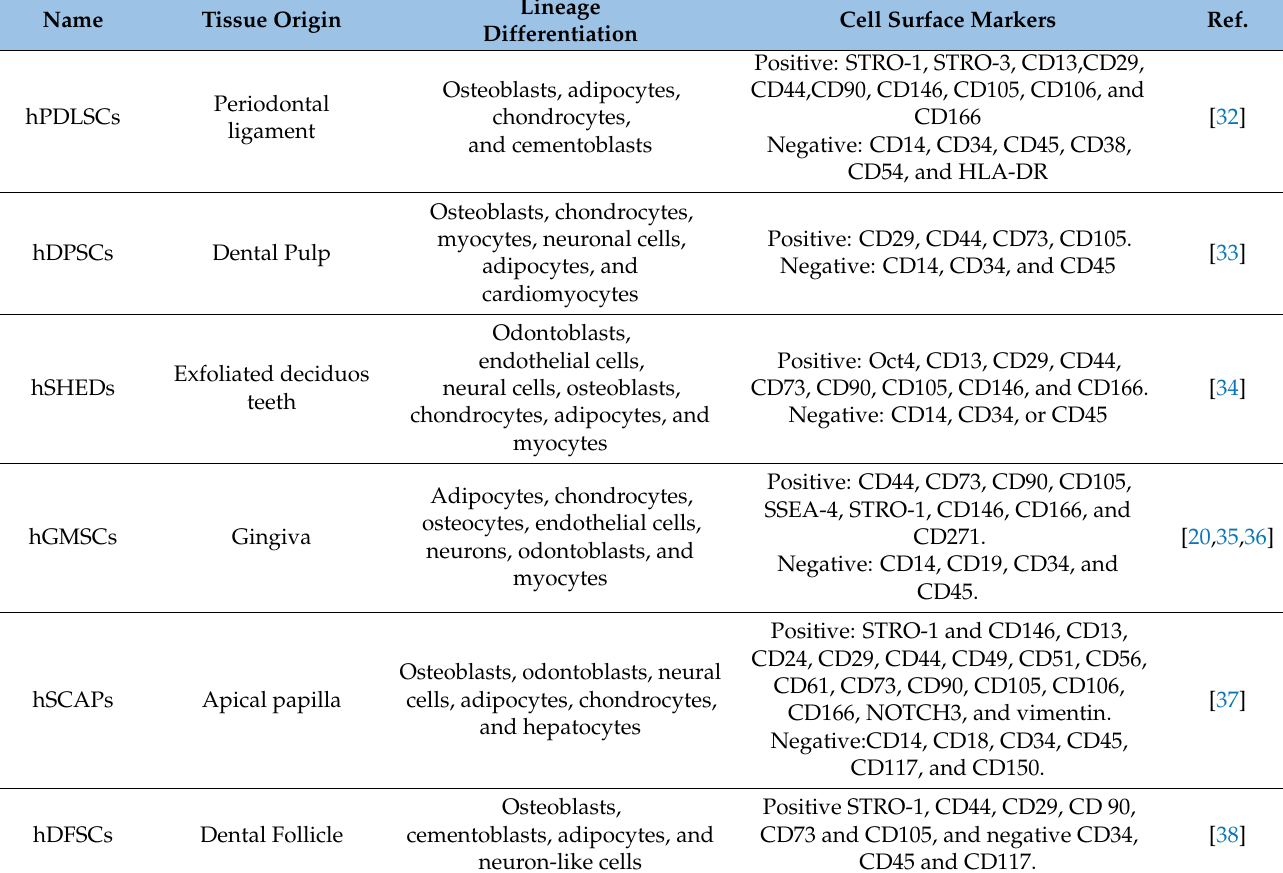
Table 2. Oral mesenchymal stem